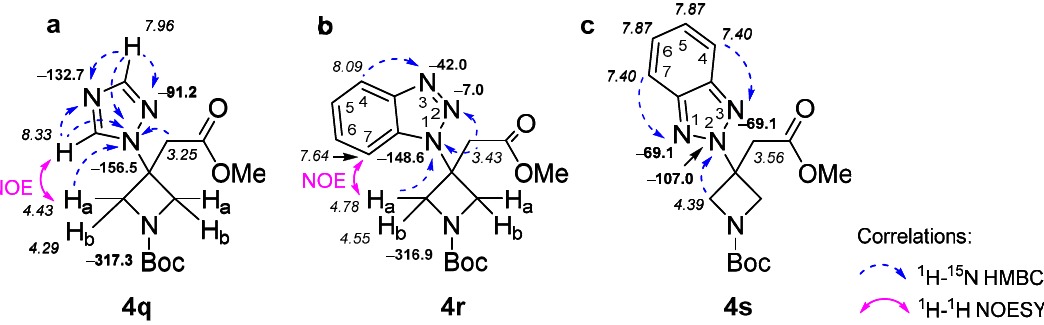
Figure 4. ( a – c ) Relevant 1 H- 15 N HMBC and 1 H- 1 H NOESY correlations, as well as 1 H-NMR